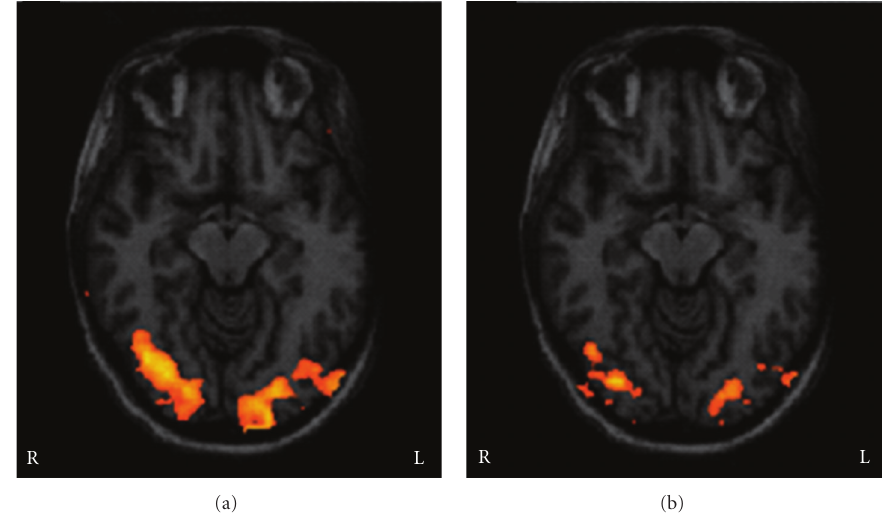
Figure 2: Activation foci evoked by stimulation of the una ff ected (a) and a ff ected eye (b) in a patient with acute left optic neuritis. Stimulation of the una ff ected side induced bilateral activation of the visual cortex; stimulation of the a ff ected side was associated with a reduced voxel size and BOLD signal in the activation foci. L and R: left and right.